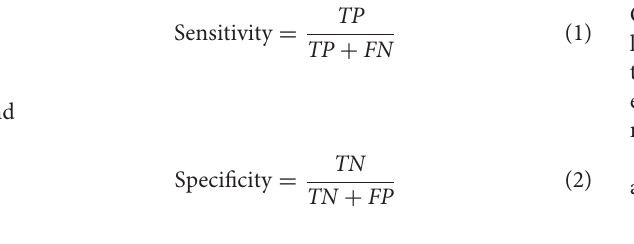
correlation function and the number of detected heartbeats in the LDV-acceleration trace, which have to be appropriately